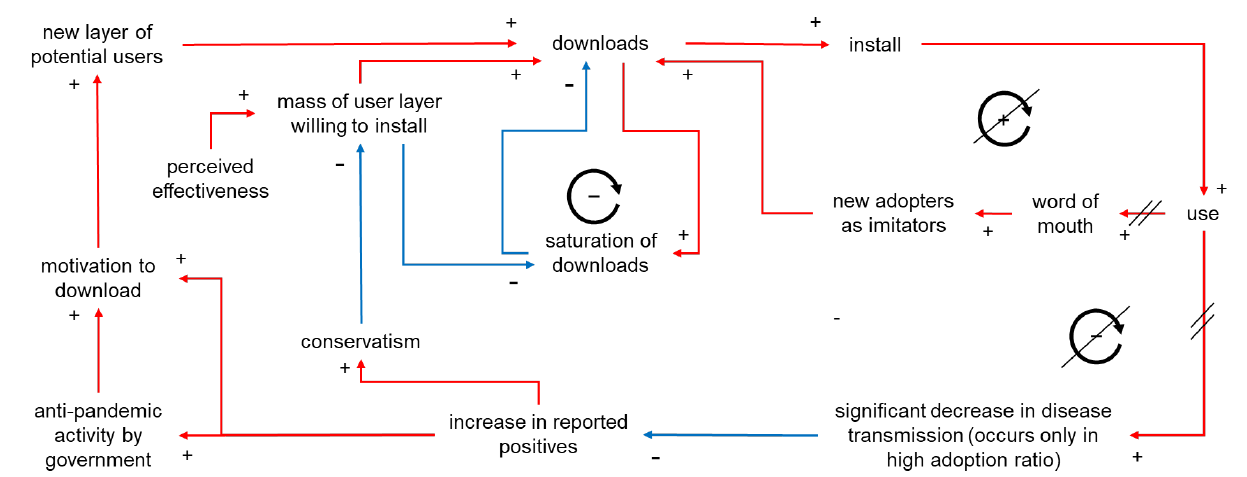
Figure 10. Causal loop diagram for the introduction of anti-COVID-19 contact tracing apps. Diagonal strike-out lines indicate that the effect was not observed in real-world settings. The circle with (+) indicates a reinforcing loop and circles with ( − ) indicate balancing loops. Red arrows indicate direct relationships and blue arrows indicate inverse relationships.